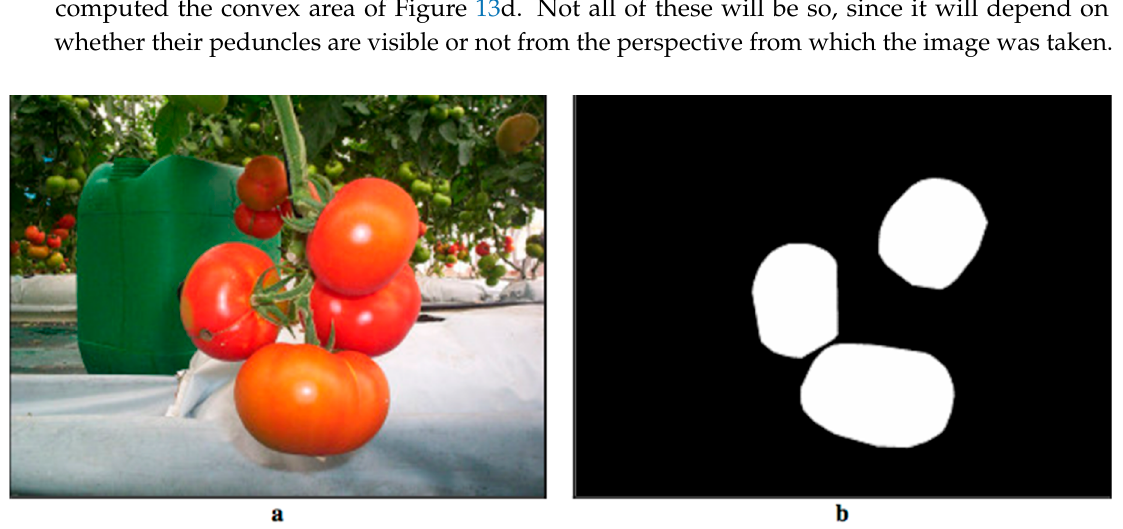
Figure 14. ( a ) Original image; and ( b ) convex area of Figure 13d.